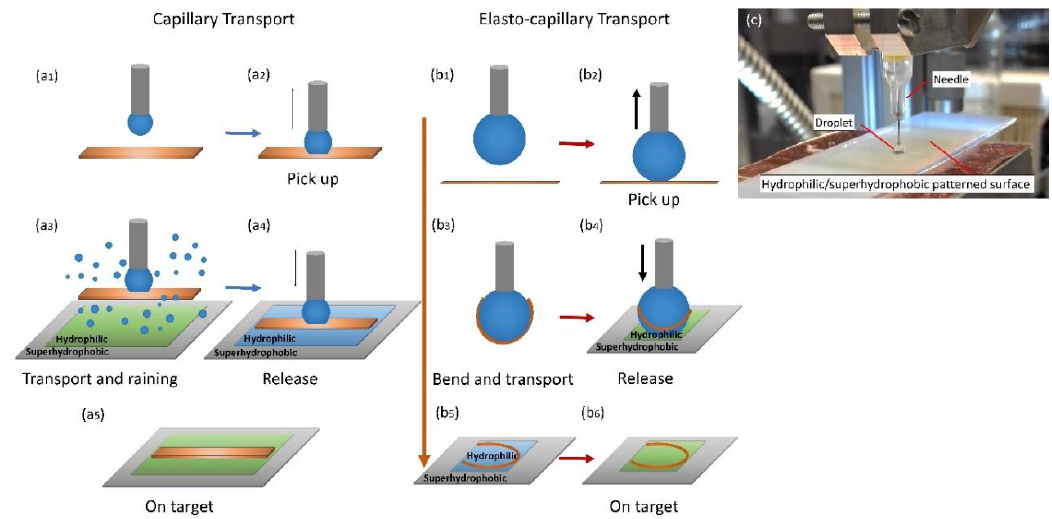
Figure 1. Schematic and system setup for transport of miniature elastic ribbons using capillary transport and elasto-capillary transport scheme. ( a 1 ) and ( b 1 ) A droplet is produced with a needle; ( a 2 ) and ( b 2 ) the needle with the droplet picks up the ribbon; ( a 3 ) the ribbon is transported to the hydrophilic / superhydrophobic patterned surface and water mist is introduced; ( b 3 , b 4 ) the ribbon bends and is transported to a hydrophilic / superhydrophobic patterned surface; ( a 4 ) and ( b 5 ) the water film is formed on the hydrophilic site and the ribbon is released on the hydrophilic site; ( a 5 ) and ( b 6 ) the ribbon is on target; ( c ) system setup for transport of elastic ribbon.